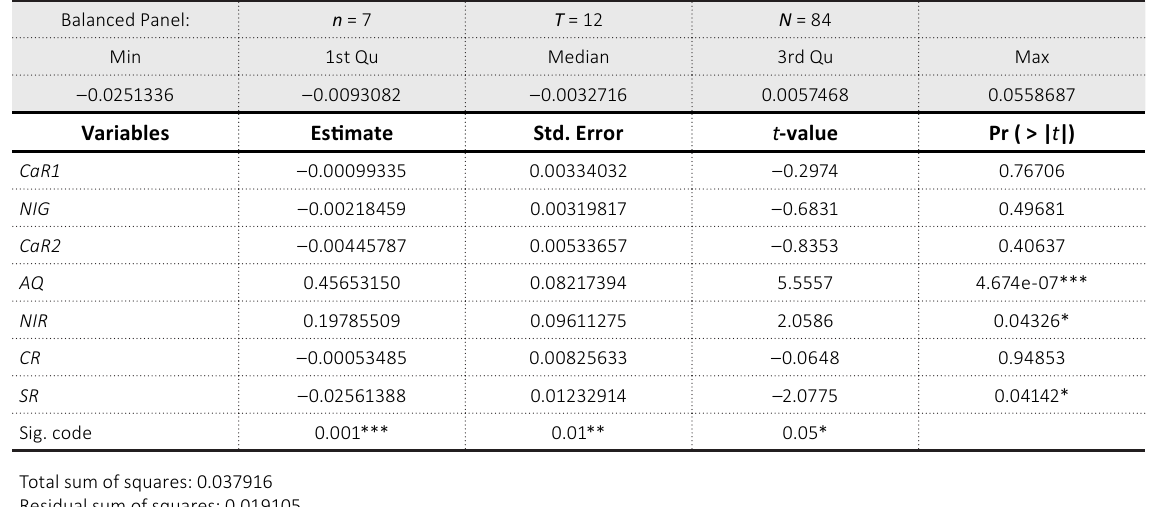
Table 6. Fixed effect regression model on Financial Stability